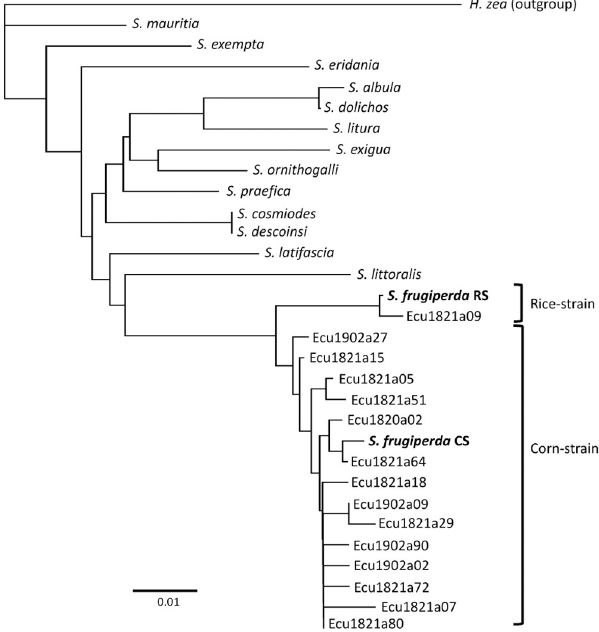
Fig 2. Phylogenetic tree inferred by using neighbor-joining method and Tamura-Nei model [40] with no outgroup. The sequences for the different Spodoptera species were obtained from GenBank. Corn-strain ( S . frugiperda CS) and rice-strain ( S . frugiperda RS) are consensus reference sequences (S1 Fig).